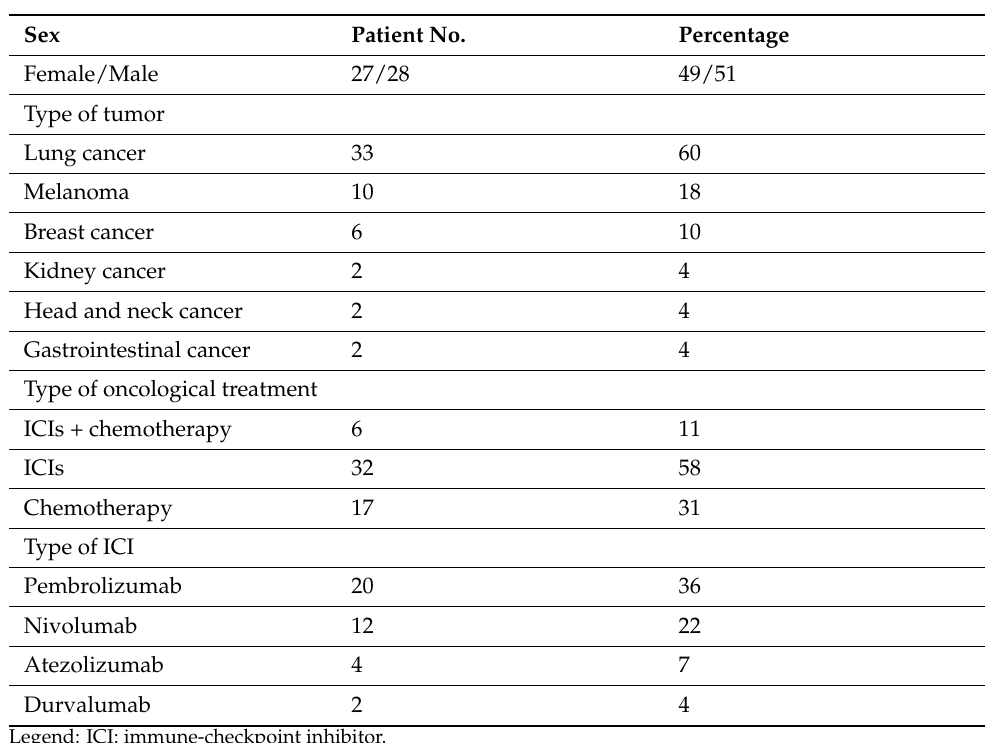
Table 1. Demographic and clinical characteristics of enrolled patients.